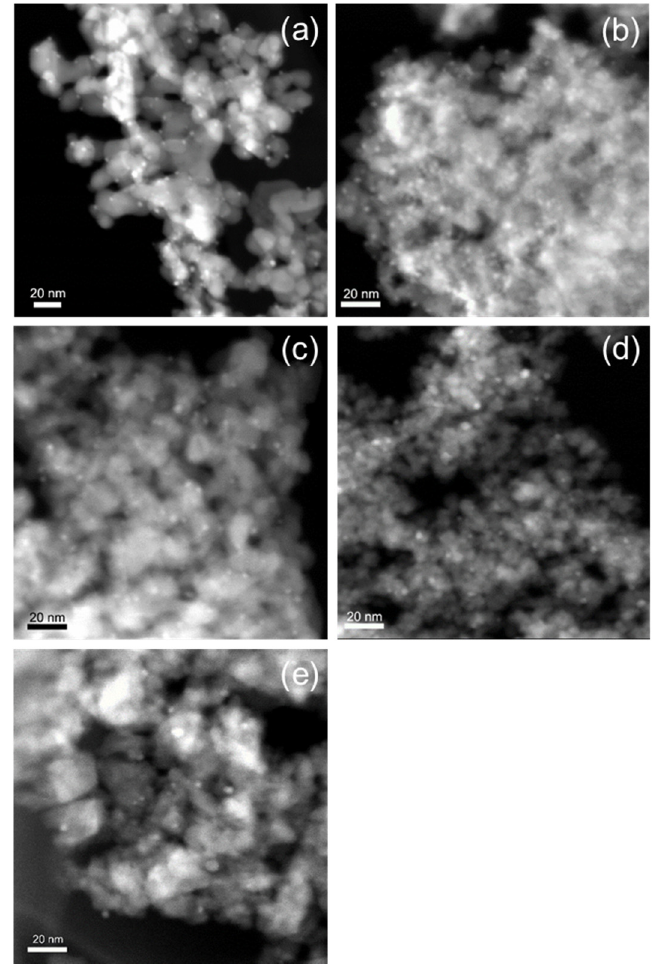
Figure 3. HAADF ‐ STEM images of ( a ) Au/ZnO, ( b ) Au/Zn 0.7 Fe 0.3 O x , ( c ) Au/Zn 0.5 Fe 0.5 O x , ( d ) Au/Zn 0.3 Fe 0.7 O x , and ( e ) Au/Fe 2 O 3 .